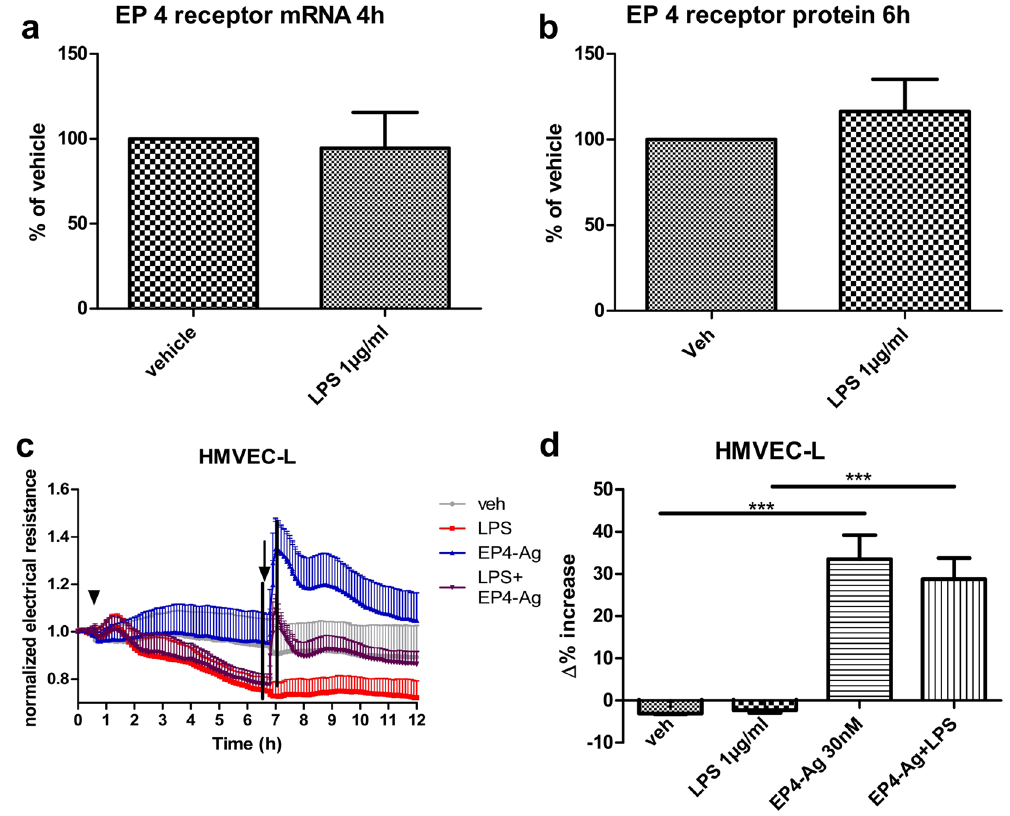
Figure 8. LPS treatment does not affect EP4 receptor expression and EP4 receptor activation restores LPS- induced disruption of HMVEC-L barrier function. HMVEC-L were treated with either LPS (1 µ g/ml) or vehicle for ( a ) 4 and ( b ) 6 hours. ( c , d ) For assessment of barrier function HMVEC-L were starved for 1 hour and treated with LPS (1 µ g/ml) or vehicle (arrowhead) for 6 hours. At this time point, an EP4 receptor-agonist ONO AE1 329 (30 nM) was added (arrow). To detect differences in barrier function (measured as change in resistance), Δ % values were calculated. The black lines mark the time points which were used to calculate Δ % increase shown in ( d ). ( a ) Data show the percentage of EP4 receptor mRNA as percent of vehicle control; ( b ): Data show the percentage of EP4 receptor protein as percent of vehicle control; ( c ): Data show mean normalized resistance + SEMs; ( d ): Δ % increase was calculated by subtracting normalized resistance of the first time point marked in c from the second time point, and multiplying the value with 100. Statistical analysis was performed using one sample t-test against 100 for ( a–b ) and one-way ANOVA followed by Bonferroni’s post hoc test for ( d ); n = 5–10; *** p <